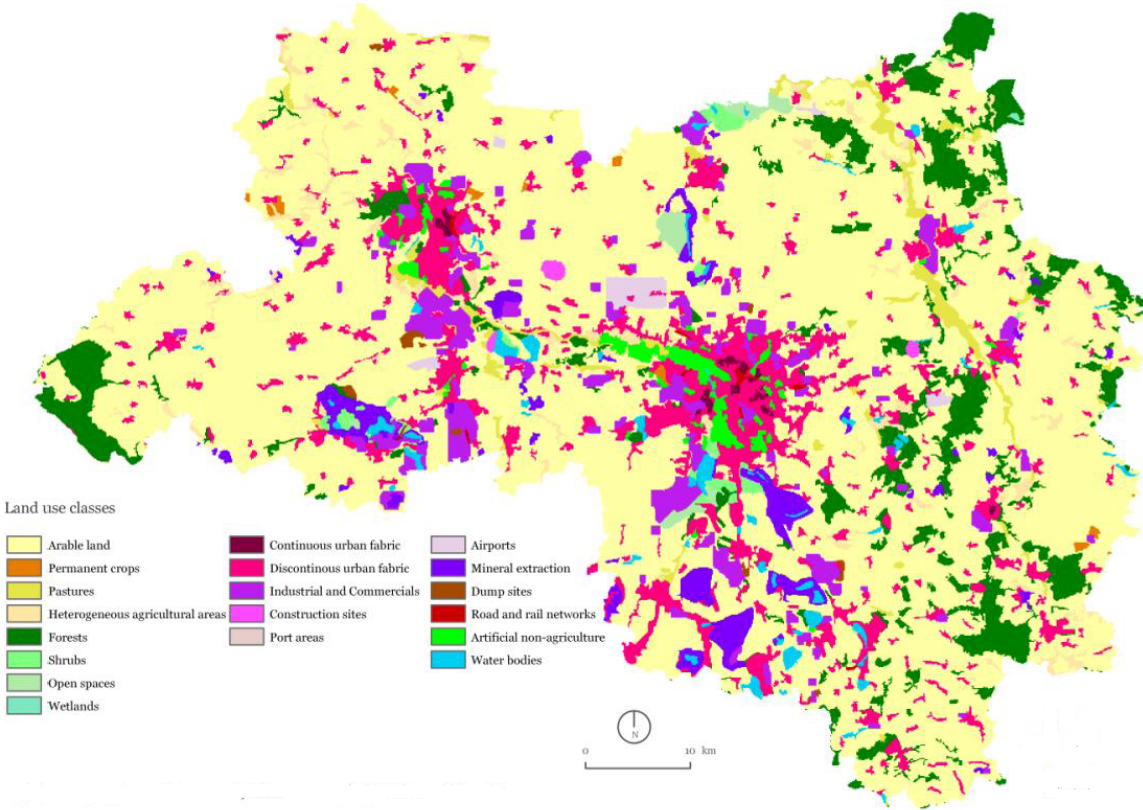
Figure 4. Leipzig 2025: Hyper-Tech